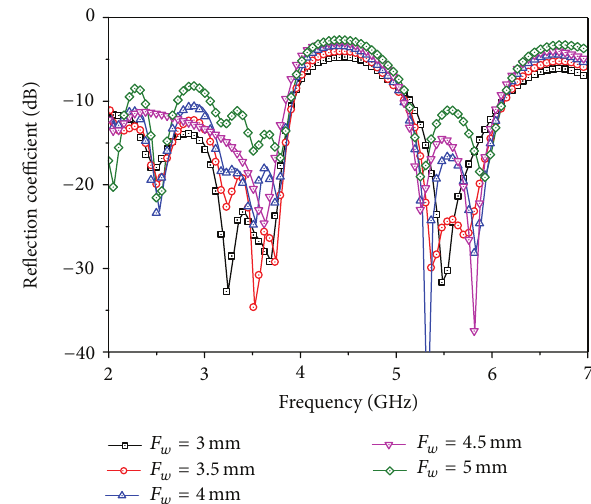
Figure 9: Effect of reflection coefficient for the different width of feed line ( 𝐹 𝑤 ).